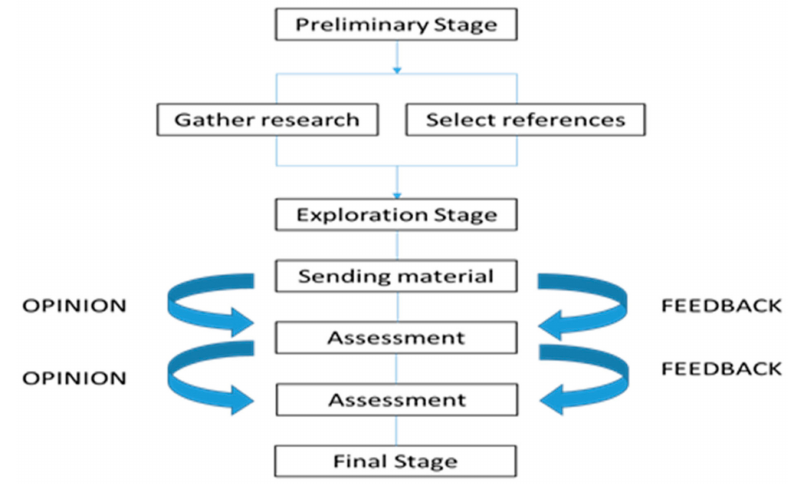
Figure 4. Description of Delphi phases.